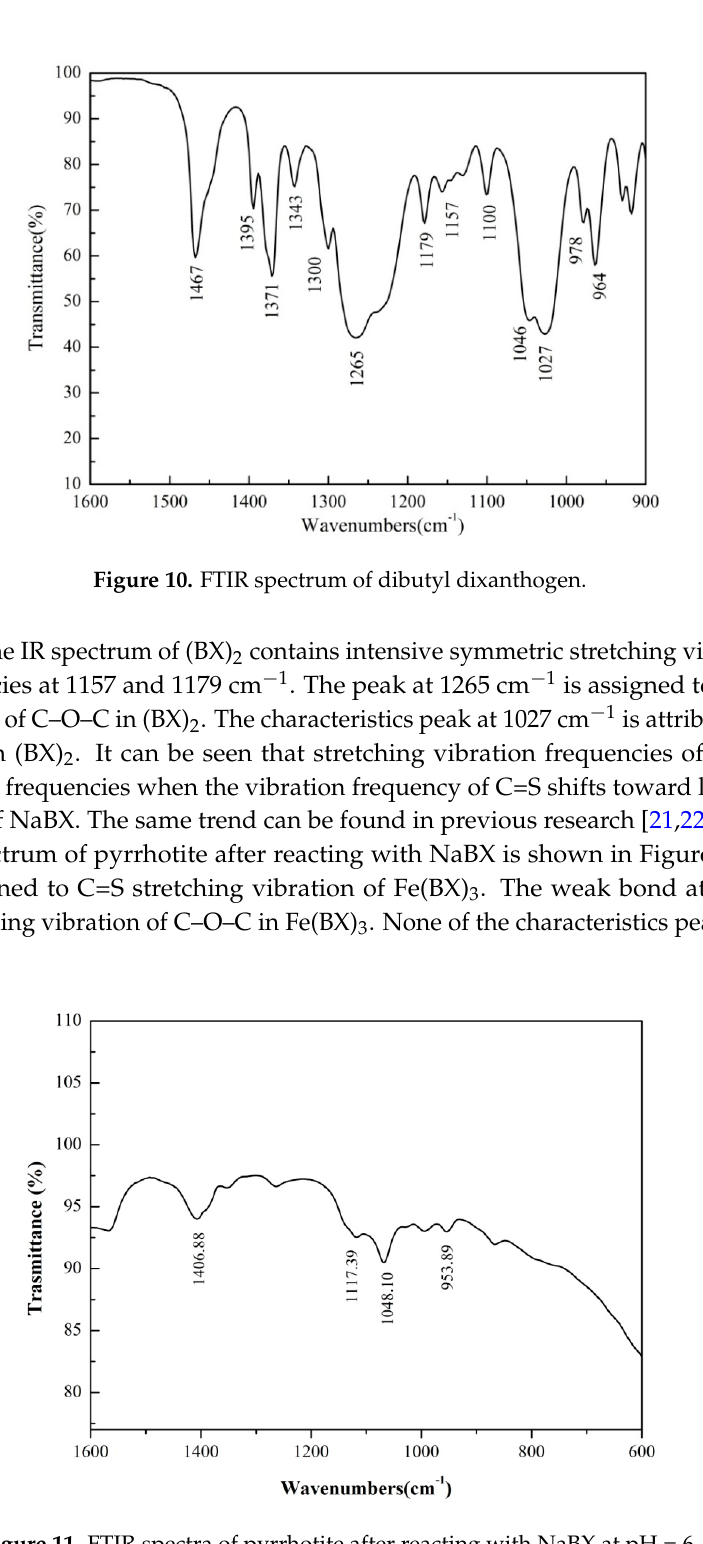
Figure 11. FTIR spectra of pyrrhotite after reacting with NaBX at pH = 6.